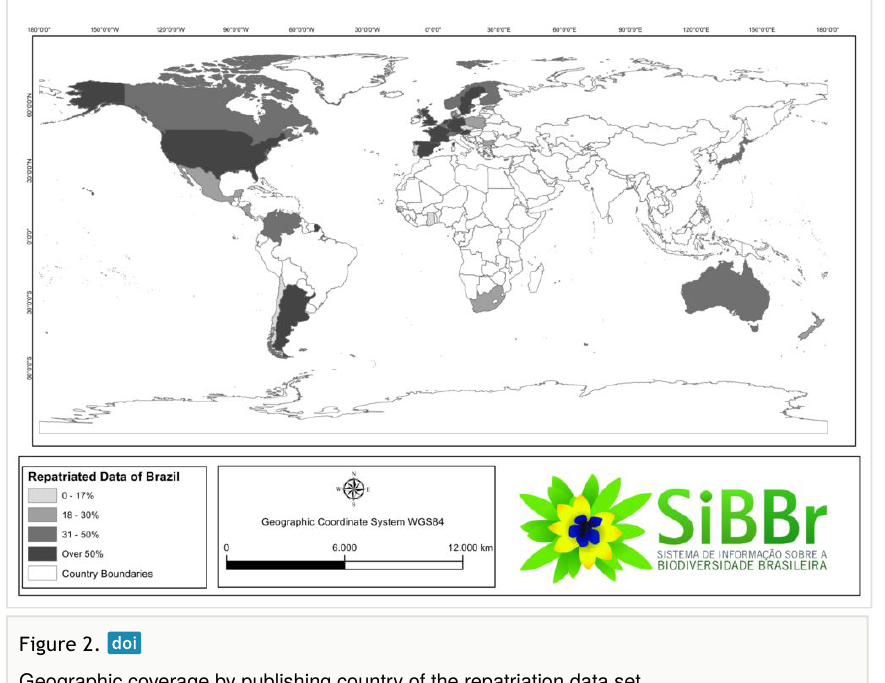
Figure 2. Geographic coverage by publishing country of the repatriation data